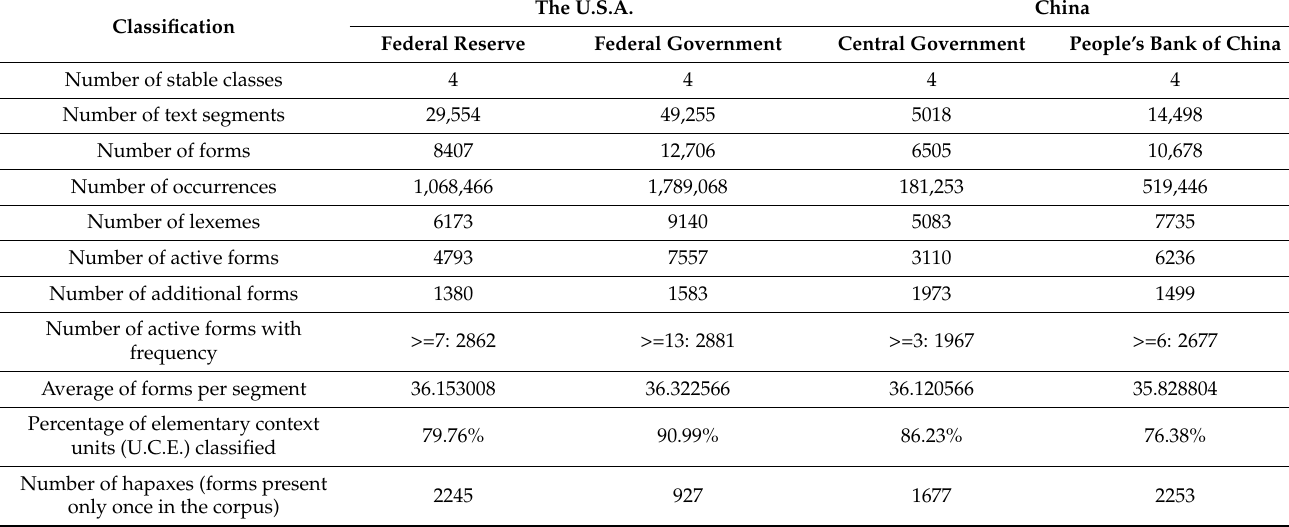
Table 2. Preliminary information on the processing of the